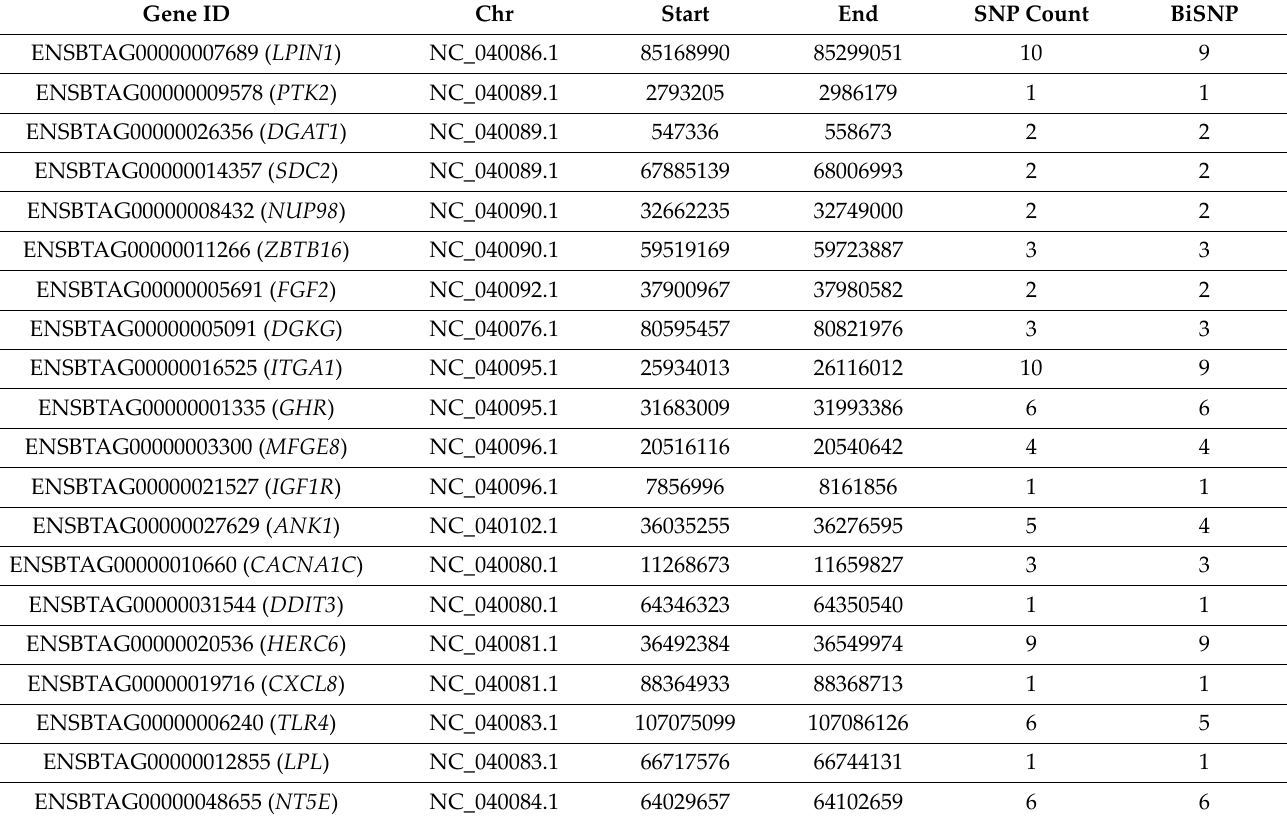
Table 2. Summary of variant analysis of differentially expressed hub and bottleneck genes.